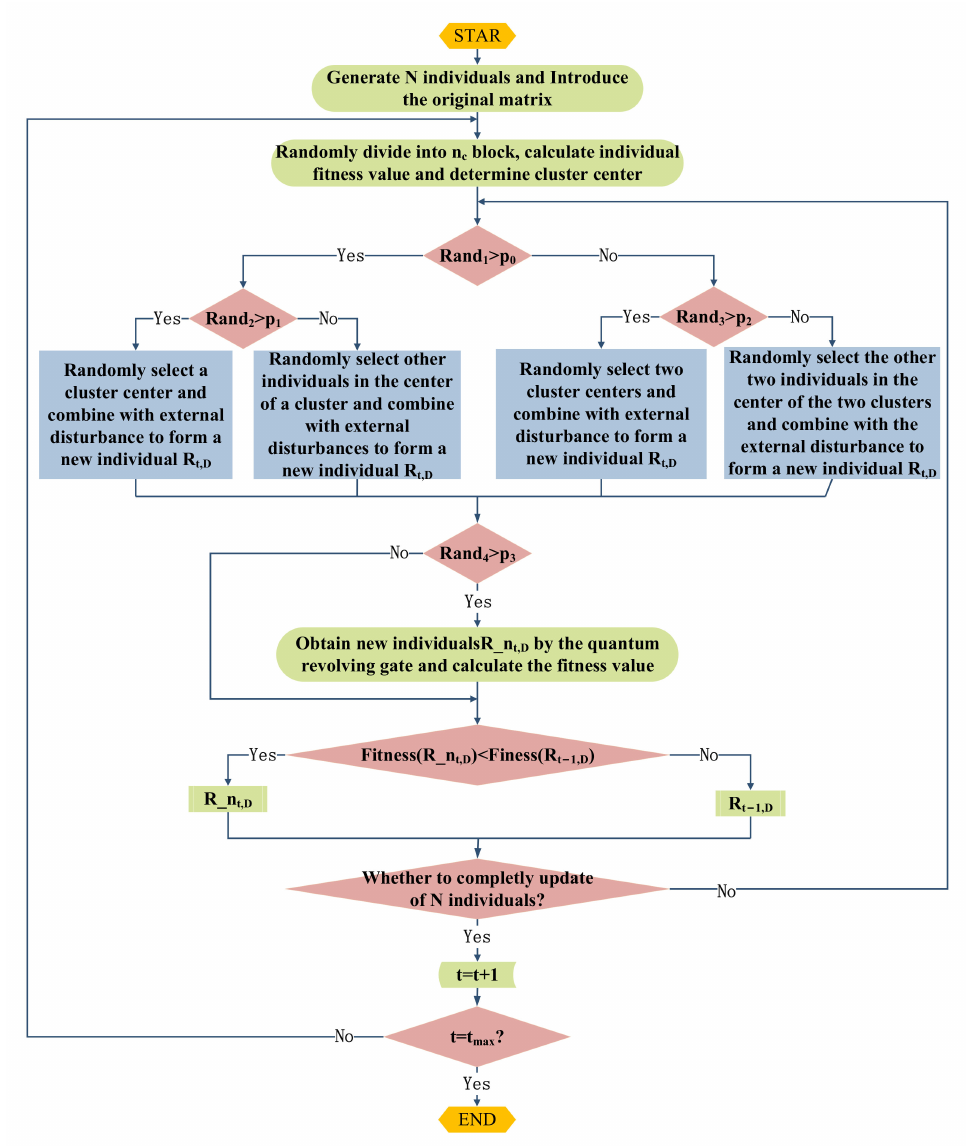
Figure 3. The flowchart of the ARGQBSO